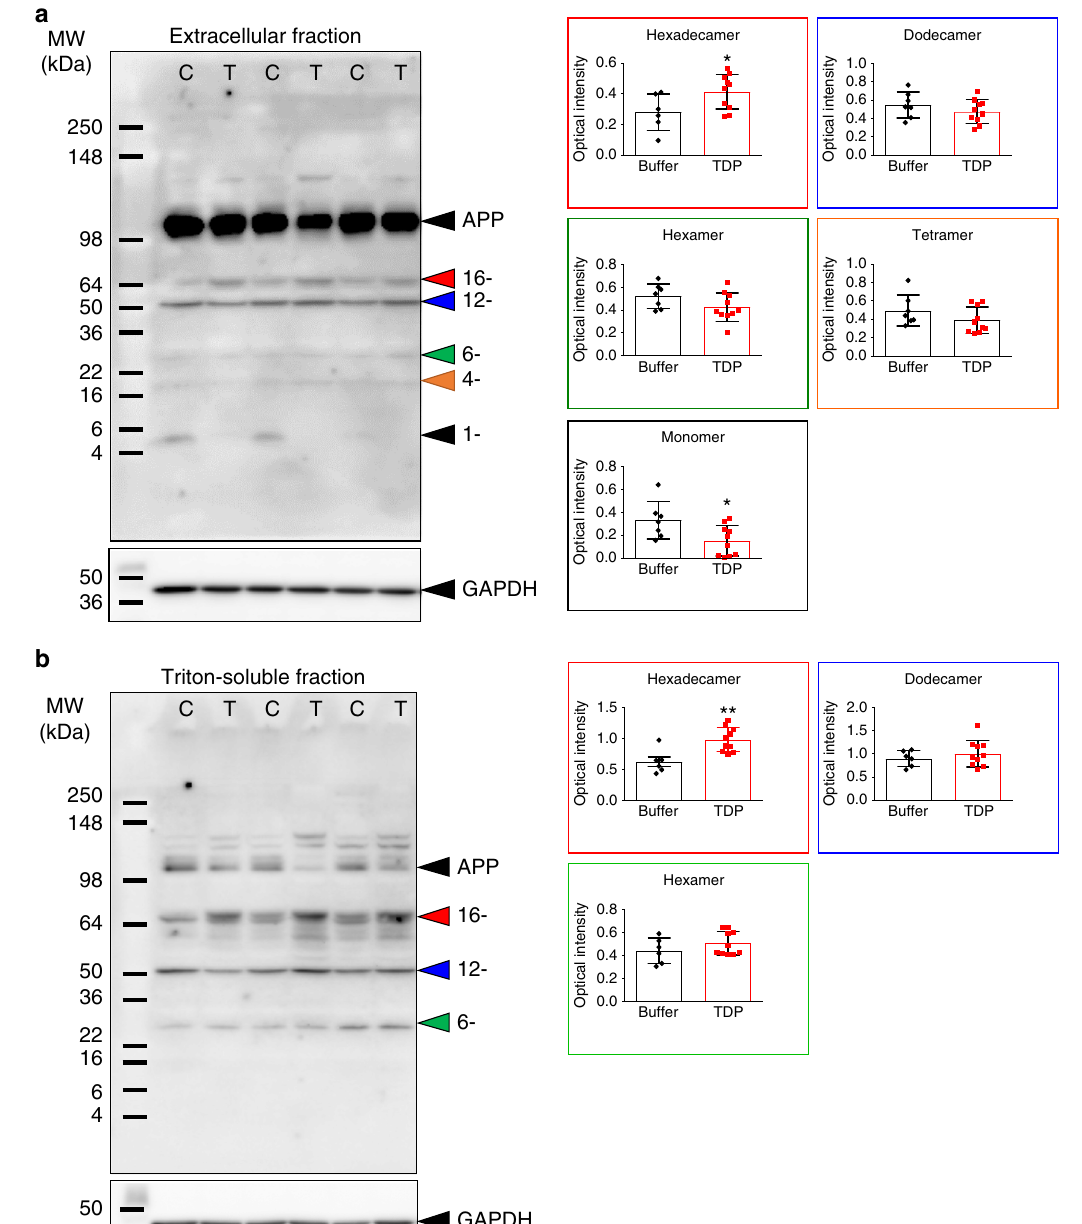
Fig. 7 TDP-43 alters A β assembly in APP/PS1 Δ E9 mice. Representative western blot of a extracellular-enriched and b Triton-soluble fraction of TDP-43- injected or buffer-injected APP/PS1 Δ E9 mice brain. A β was detected and quanti fi ed in different assembles. TDP-43 group is denoted as T, and the buffer group is denoted as C. The quantitative results of each A β assembly in TDP-43-injected ( n = 6) or buffer-injected ( n = 10) APP/PS1 Δ E9 mice were shown on the right panels. The averaged data and s.e.m. are plotted. The statistical analysis was performed by two-tailed Mann – Whitney test, * p < 0.05, ** p < 0.01 (for extracellular-enriched fraction, Hexadecamer: Buffer vs. TDP-43, p = 0.042; Monomer: Buffer vs. TDP-43, p = 0.043; For Triton-soluble fraction, Hexadecamer: Buffer vs. TDP-43, p = 0.005). Source data are provided as a Source Data fi (~94%) and a few with amyloid plaques (~6%) (Fig. 6c, d). We with a mixture of two rabbit TDP-43 antibodies 10782-2-AP and further conducted immunoprecipitation (IP) to examine the 12892-1-AP. These antibodies recognize both human and mouse interaction between A β and TDP-43 (Fig. 6e) in TDP-43-injected TDP-43. IgG was used as a negative control. The IP data showed APP/PS1 Δ E9 mice. We fractioned the mouse frontal cortex into that ~43 kDa TDP-43 band, most likely full-length TDP-43, was extracellular-enriched fraction, Triton-soluble fraction, and gua- pulled down with A β but not with the negative control in the nidine hydrochloride (GdnHCl)-soluble fraction in accordance extracellular-enriched and Triton-soluble fractions. The result with the procedure described in the method. The mixture of A β demonstrated that TDP-43 interacts with A β in extracellular- antibodies 6E10 and 4G8 was used to pull down A β and the enriched and Triton-soluble fractions of the APP/PS1 Δ E9 mouse associated proteins in the extracellular-enriched and Triton- frontal cortex. Furthermore, in fl ammation was examined by soluble fractions from the frontal cortex. The eluents were probed Iba1 staining for microgliosis. TDP-43 injection to APP/PS1 Δ E9